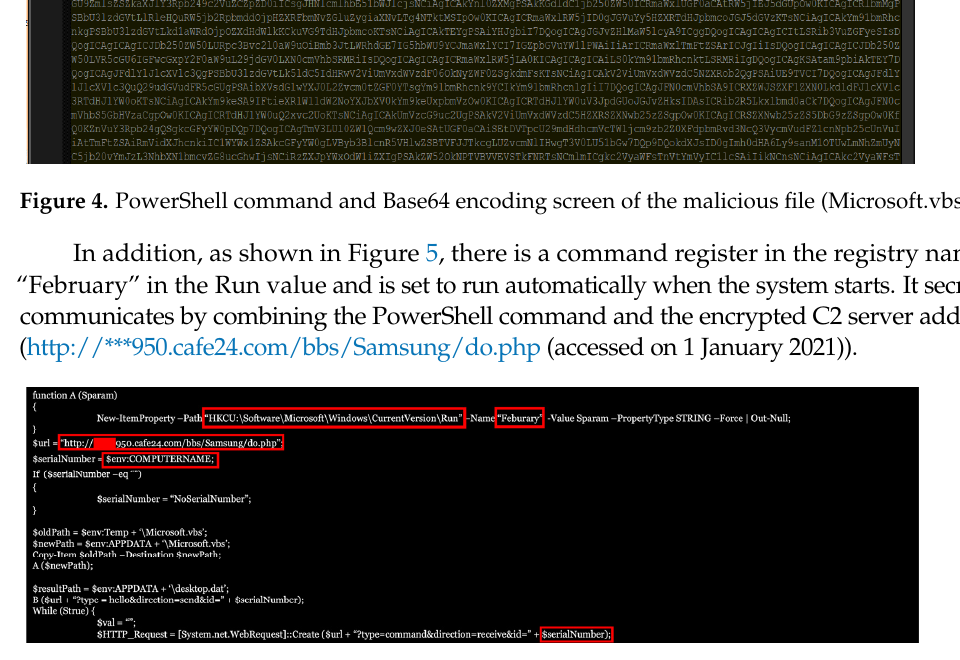
Figure 5. Registration screen of registry and screen for setting communication with C2 server.